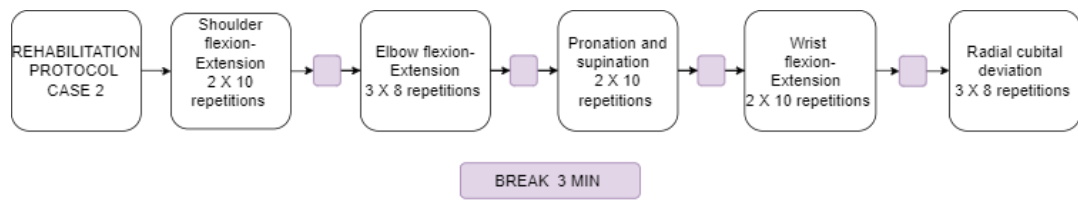
Figure 15. The rehabilitation protocol case 2.